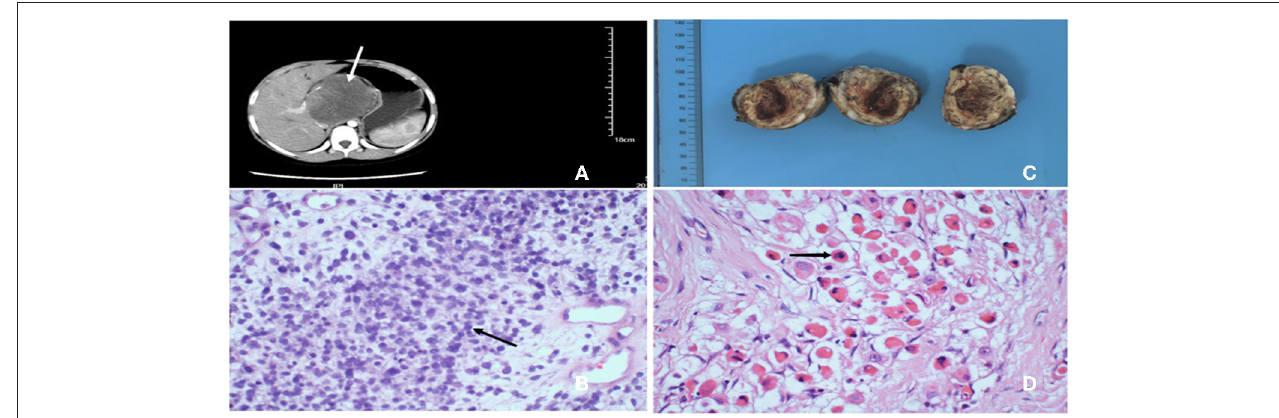
FIGURE 1 | (A) Abdominal enhanced computed tomography showing a 7.5*7.3*7.7cm high-density mass lesion involving left hepatic lobe, tending to be malignant. (B) After percutaneous liver biopsy, H&E stained showed the lession was composed of numerous large and small round cells, haphazardly oriented, containing variable amount of cytoplasm and prominent nucleolus (40 × ). (C) Postoperative specimen revealed a 5.5*5.0*4.0cm well-defined soft mass with a gray/yellowish/reddish brown cut surface, in which hemorrhage, necrosis and cystic lesion could be seen. (D) H&E stained of the tumor revealed typical rhabdomyoblasts (black arrow) with oval nucleus, median nucleolus and eosinophilic cytoplasm (40 × ).